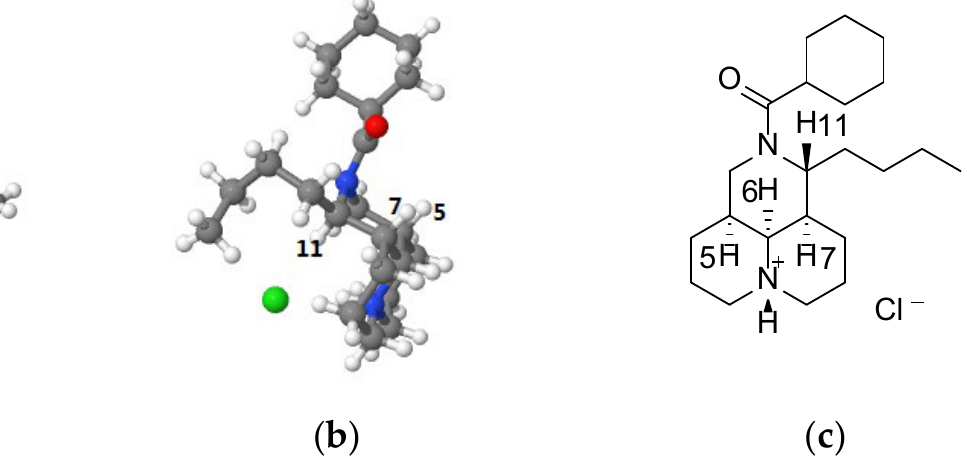
Figure 2. Single-crystal structure of hydrochloride of compound 15 . ( a ) front view; ( b ) side view; ( c ) structure of hydrochloride of 15 .